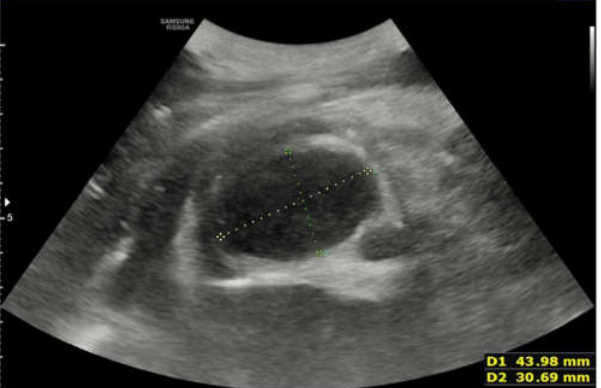
Figure 5. Ultrasound performed on the second day of stay. An hypoechogenic and inhomogeneous oval-shaped formations measuring 43 × 30 mm is seen.